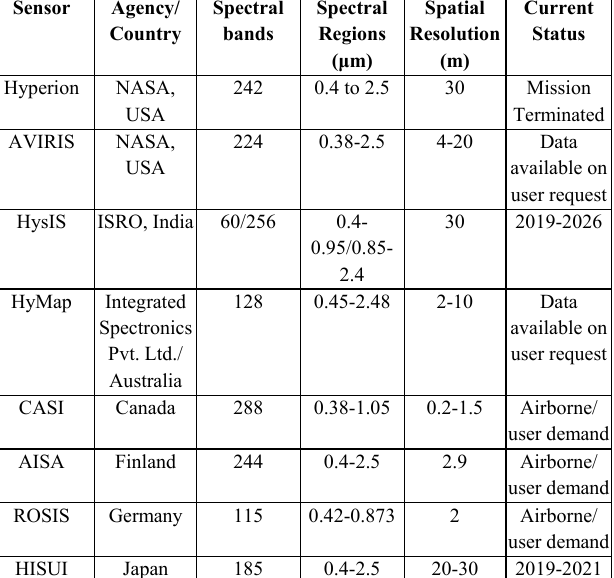
Table 1: Current status of hyperspectral satellite data of different agencies.